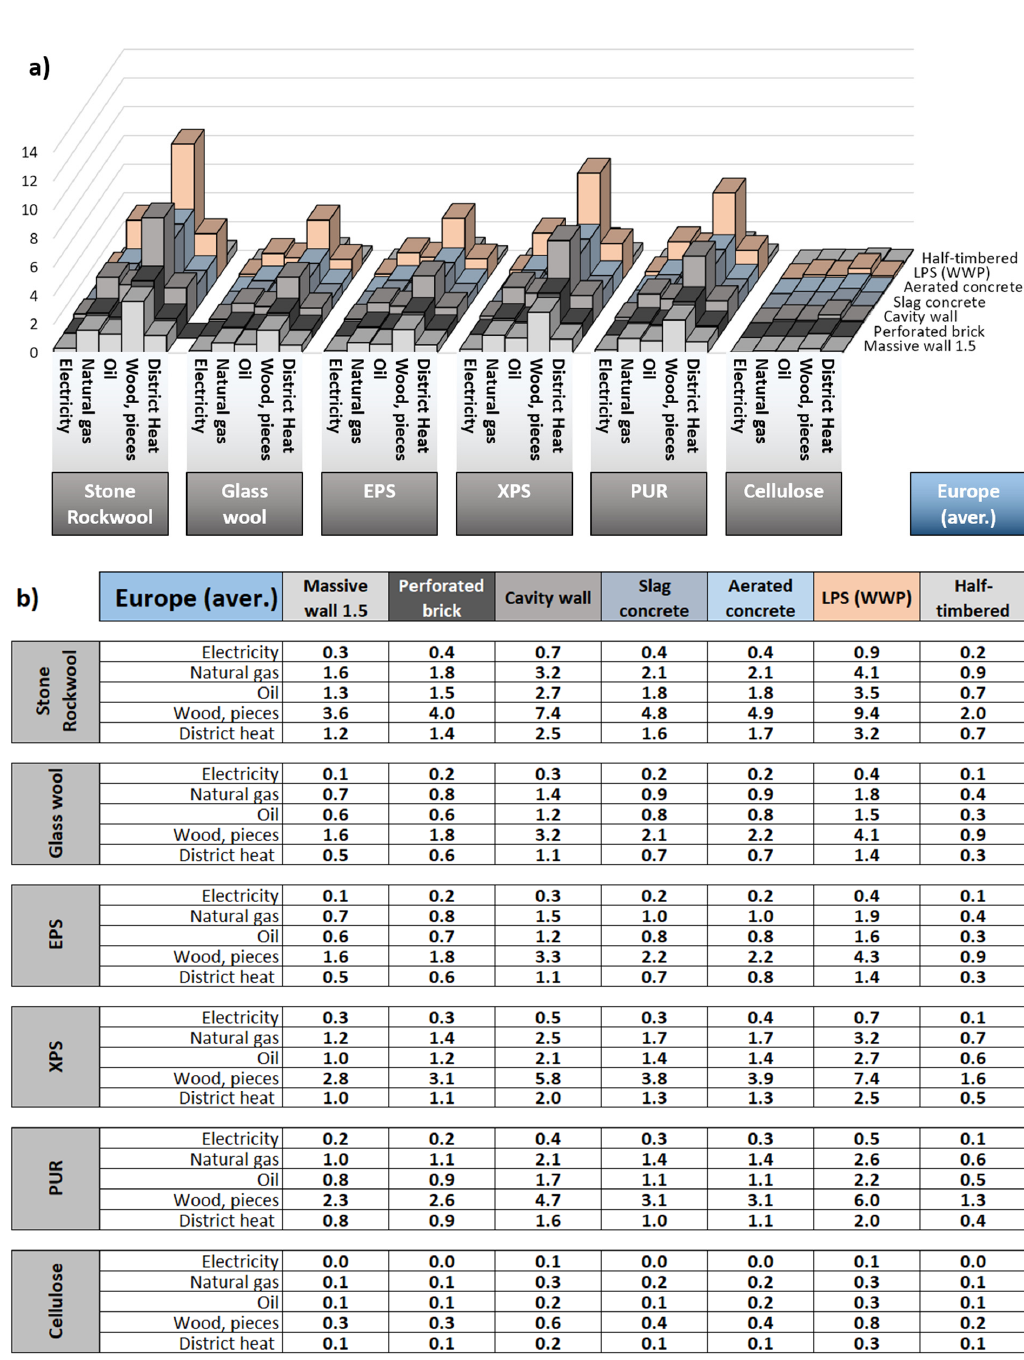
Figure 3. ( a ) CPP values chart for Europe (aver.), ( b ) CPP values for Europe (aver.). After calculating the average values from the available 270 EPDs, averaged PEFn val- ues, emission factors and climatic conditions, the longest CPP is found in stone-/rockwool- insulated walls (up to 9.4 years in the case of an LPS (WWP) wall with initially the highest resistance and in the space heated with biomass). Stone/rockwool has the highest CPP values due to the high value of embodied carbon (C E ) for 1R ∙ m − 2 , owing to both high-